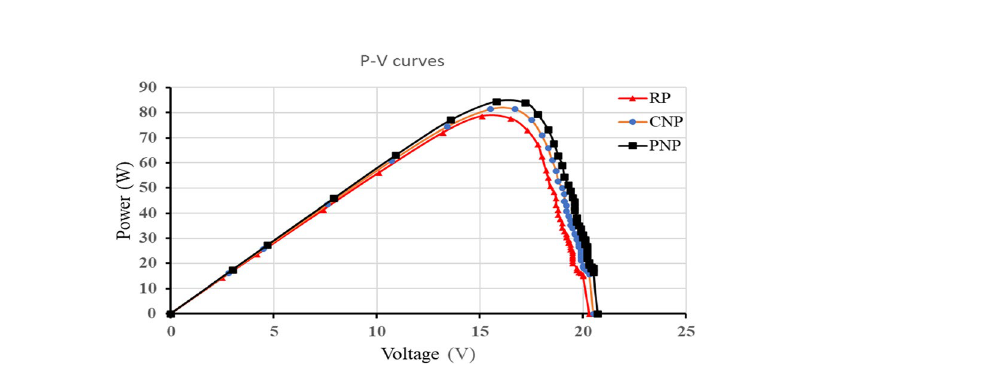
Figure 12. The P–V curves for RP, CNP, and PNP.